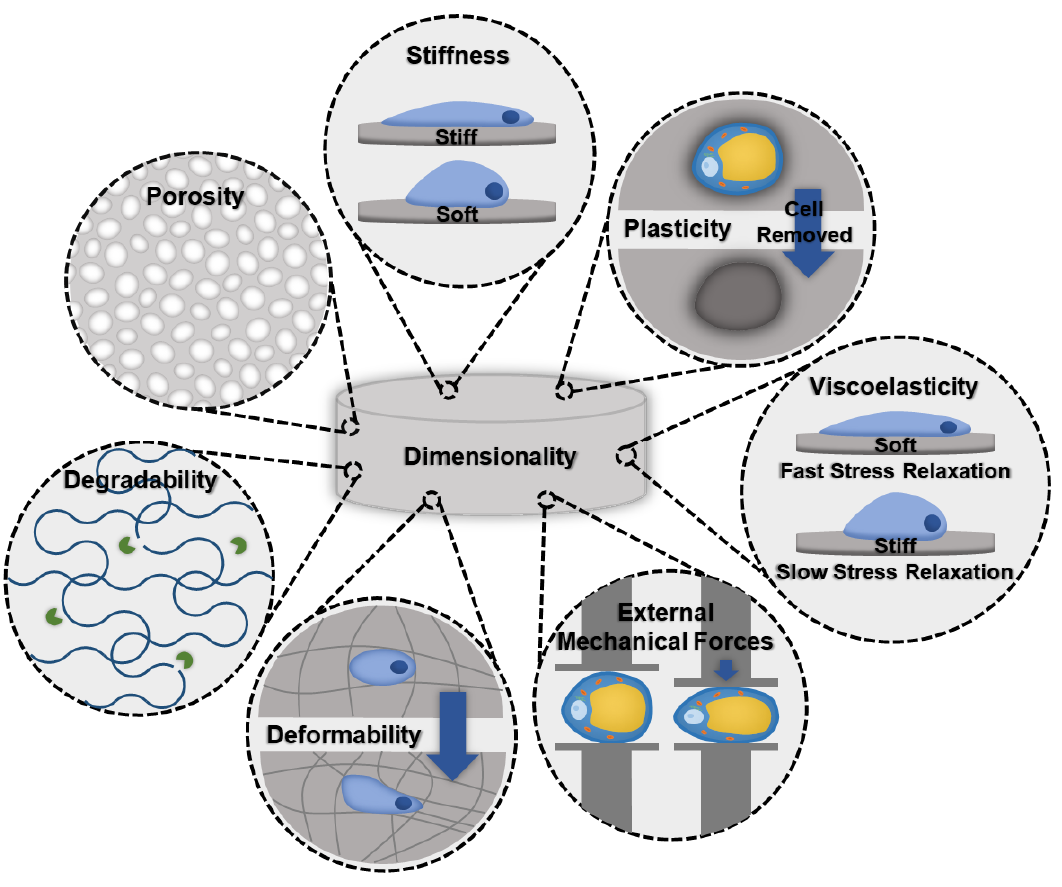
Figure 2. Schematic illustrating important biomaterial properties that should be considered when designing an in vitro fibrotic adipose tissue model.